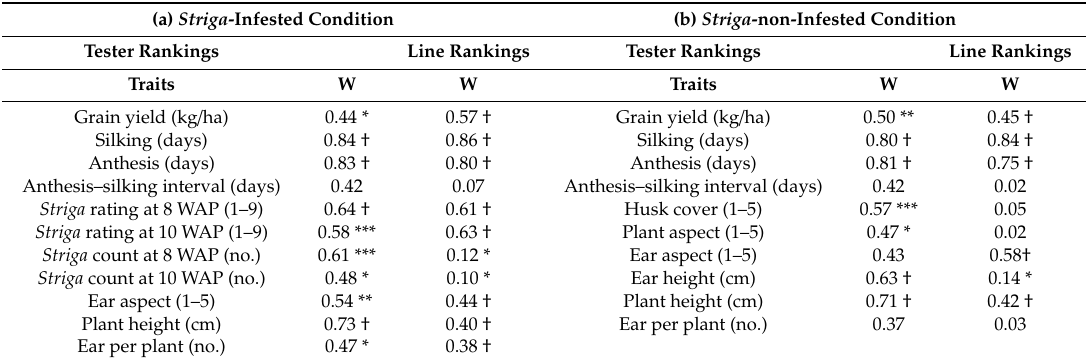
Table A4. Consistency of line and tester rankings using Kendall’s coe ffi cient of concordance (W) across environment under (a) Striga -infested and (b) non-infested